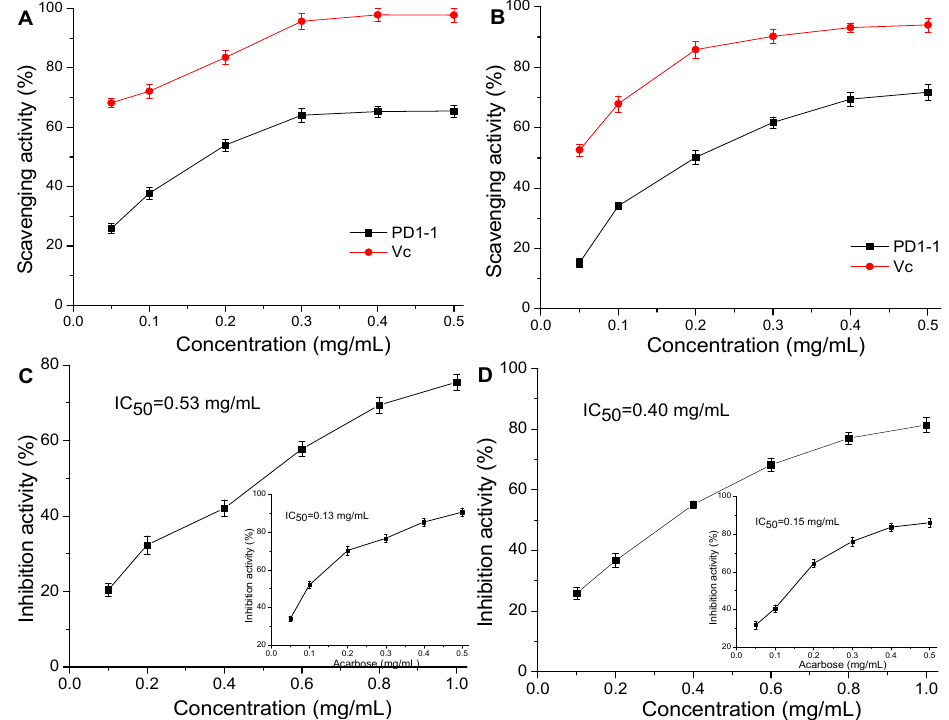
Figure 5. Antioxidant and hypoglycemic activities of PD1-1 in vitro. ( A ) DPPH radical scavenging activity; ( B ) hydroxyl radical scavenging activity; ( C ) α -glucosidase inhibitory activity; and ( D ) α -amylase inhibitory activity. Data presented as mean ± SD.